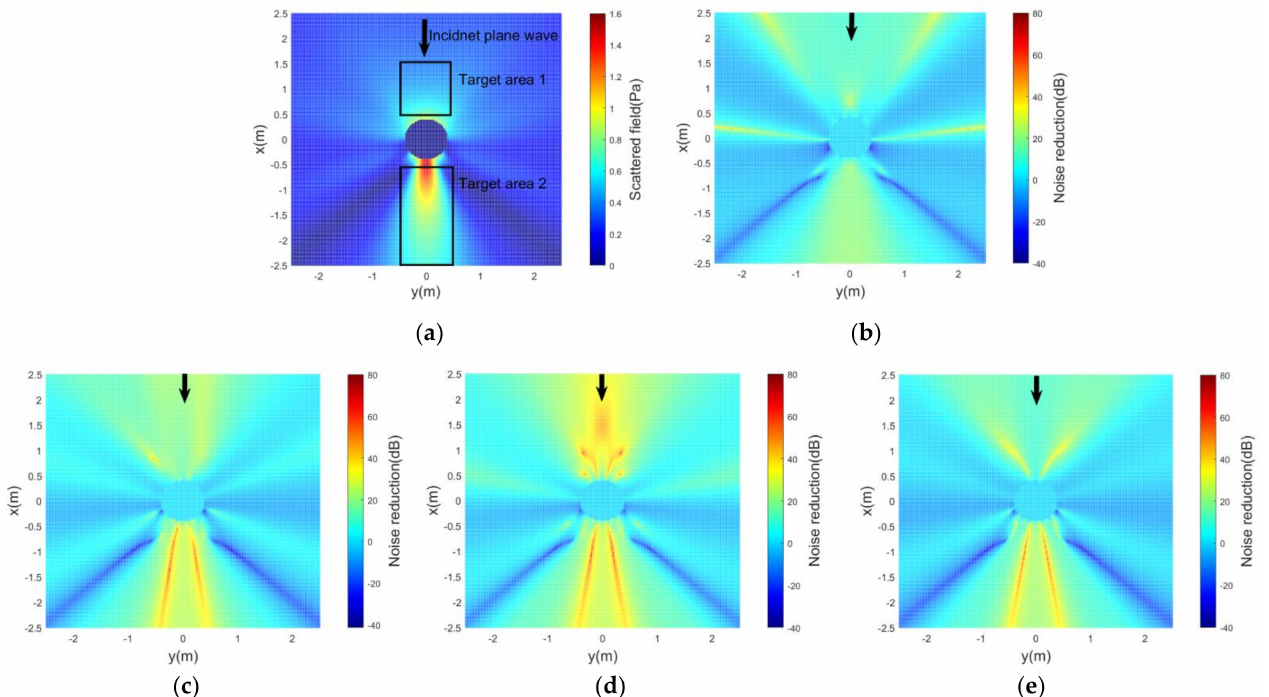
Figure 3. Scattered sound field and the control performance for each method at 700 Hz: ( a ) scattered sound field of the 700 Hz primary source; ( b ) control performance of the Uni-RLS algorithm(700 Hz); ( c ) control performance of the LASSO-RLS- γ C algorithm ( d ) control performance of the proposed CLASSO-RLS algorithm (700 Hz); and ( e ) control performance of the LASSO-RLS- γ NL algorithm (700